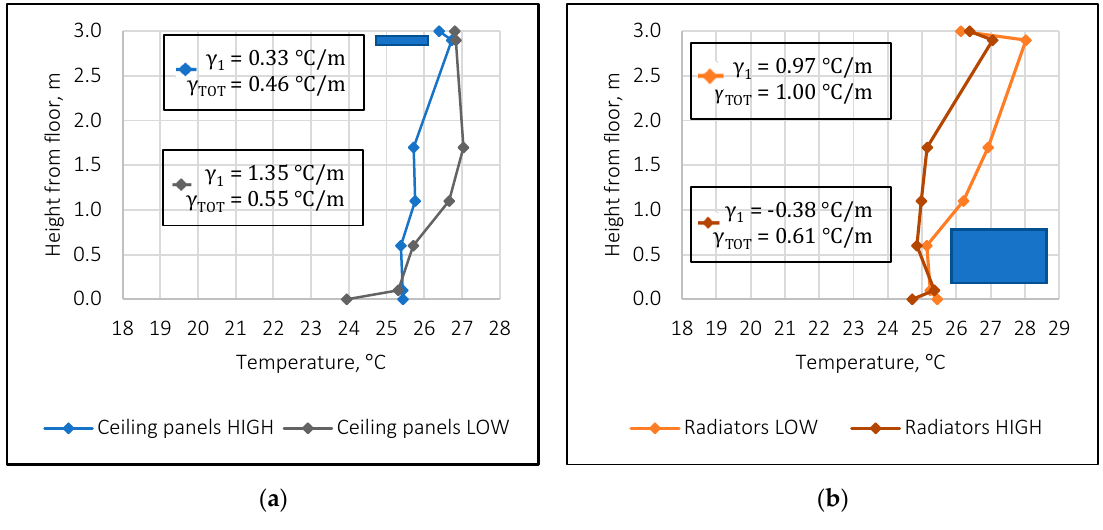
Figure 10. Measured temperature gradient of ceiling panels ( a ) and panel radiators ( b ).